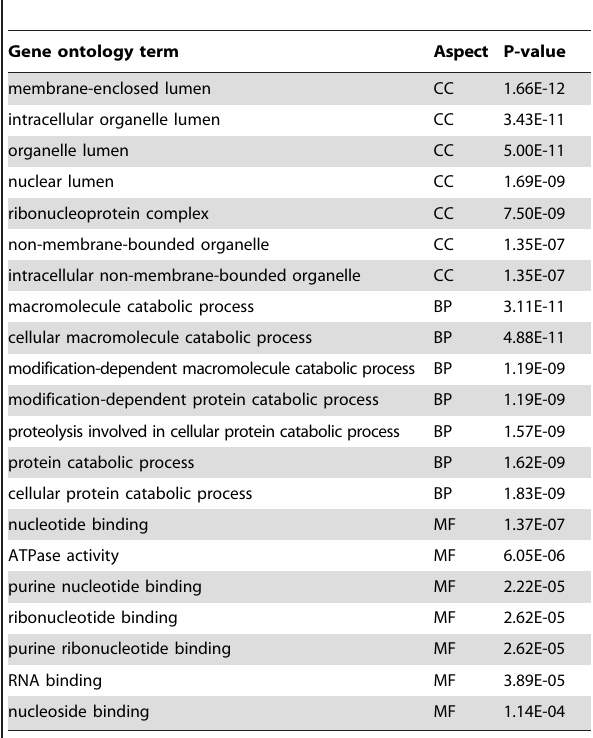
Table 1. Gene ontology analysis for the transactive genes associated with PADI4 binding in MCF-7